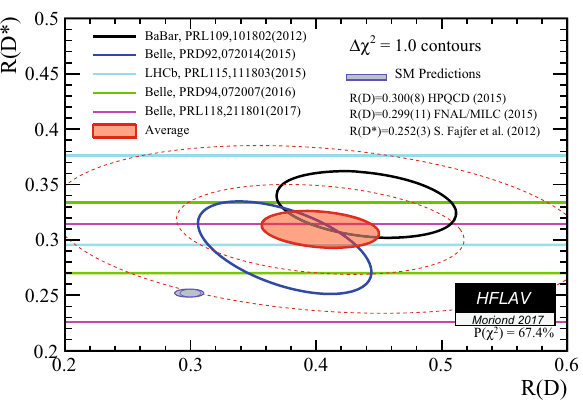
Fig. 66 Measurement of R ( D ) and R ( D ∗ ) and their average com- pared with the prediction for R ( D ∗ ) [577] and R ( D ) [494,573]. The dashed ellipses corresponds to the 2 and 4 σ contours